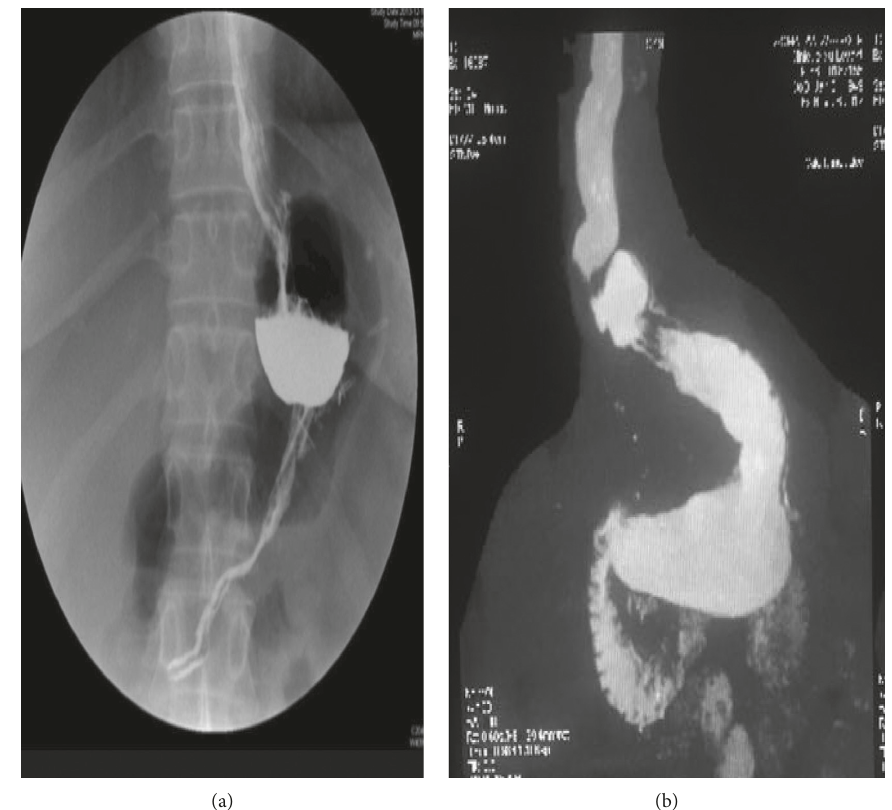
Figure 1: Group A: (a) dilated residual fundus; group B: (b) dilated remnant antrum.